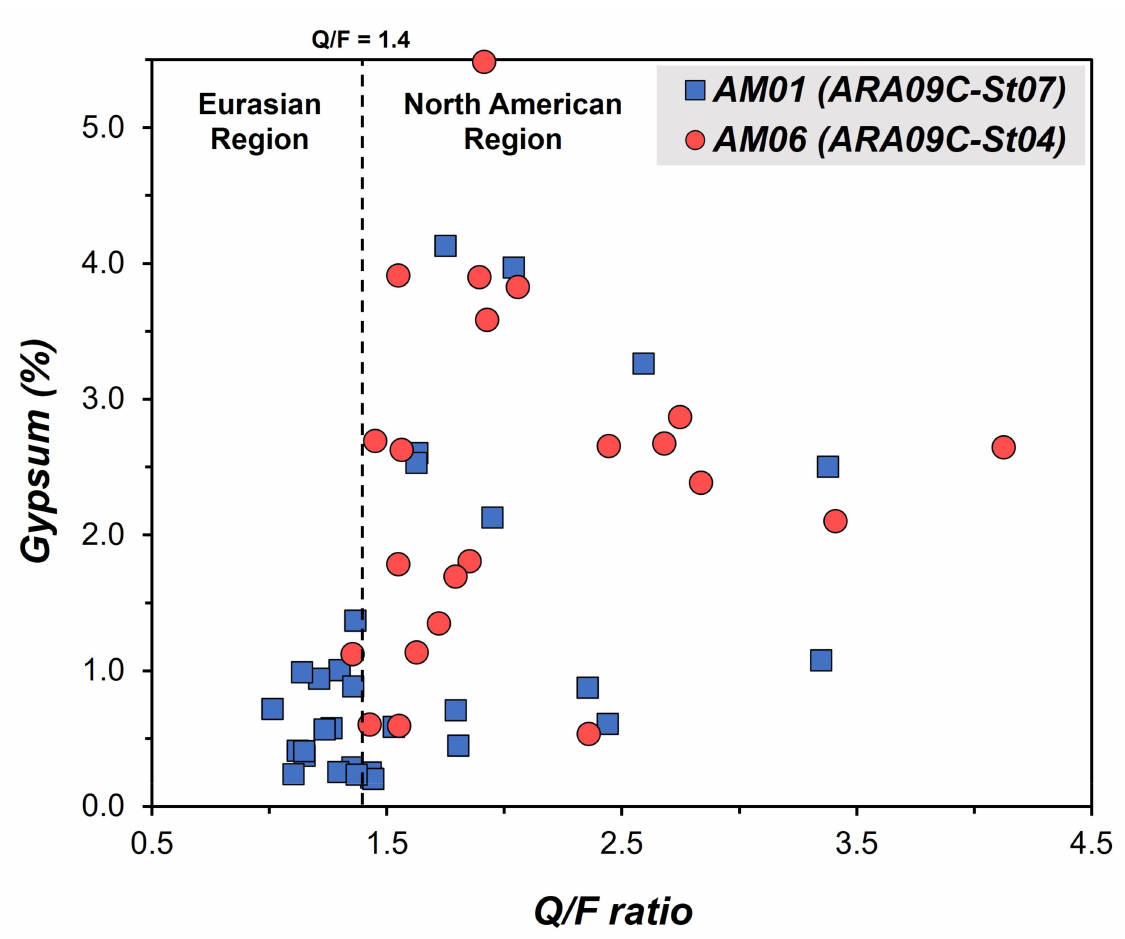
Figure 5. Correlation plot of the quartz/feldspar (Q/F) ratio with gypsum for the ARAON Mound cores. The boundary of sediment provenance is established based on the mineral data in the work by Darby et al. [29].